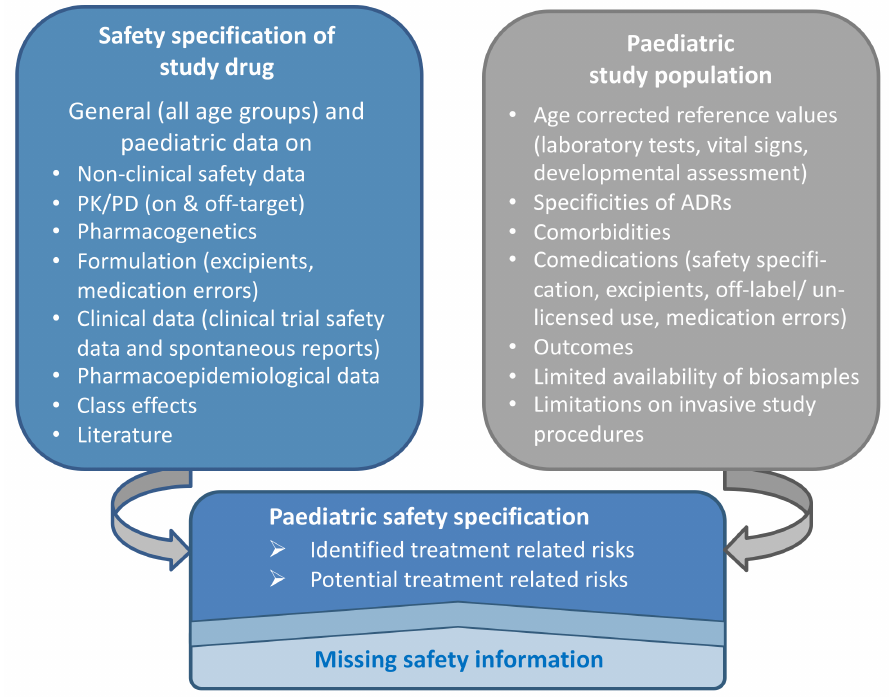
Figure 2. Data informing the paediatric safety specification. ADR—Adverse drug reaction; PK— Pharmacokinetic;